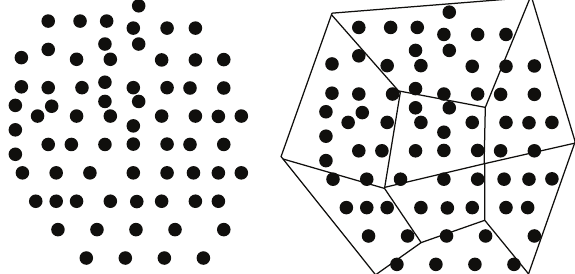
Figure 5: Primary data and the classification.